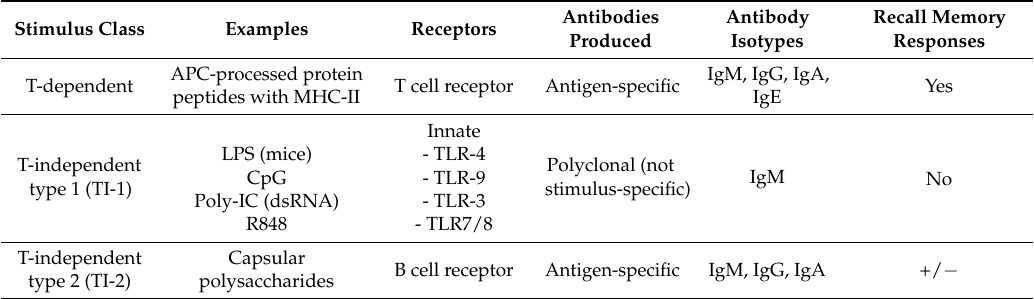
Table 2. The primary stimuli and receptors generating antibody responses. APC, antigen